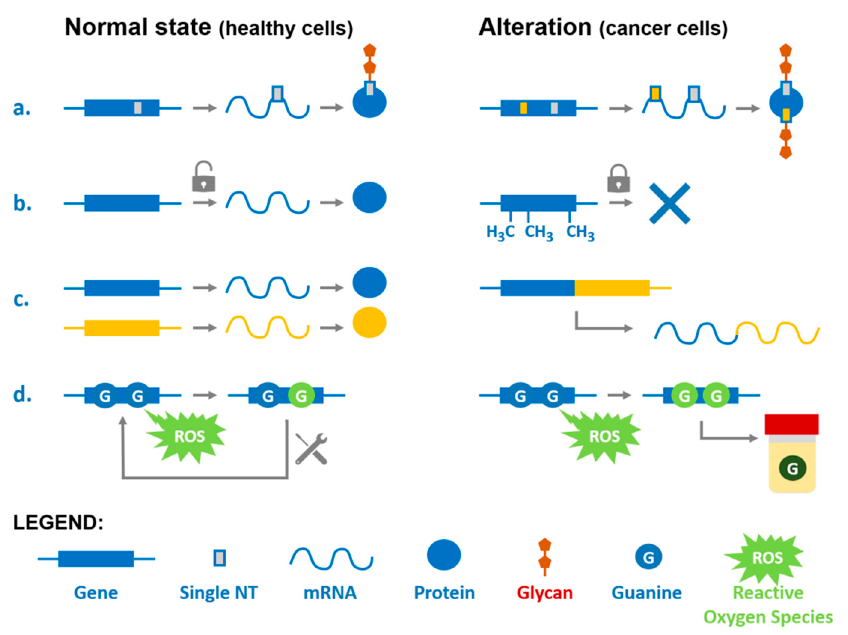
Figure 6. DNA changes associated with PCa. Schematic presentation of changes associated with PCa on DNA level (right) compared to normal conditions (left): ( a ) changes associated with a single nucleotide change (point mutation), possibly leading to another amino acid present in the protein primary structure and occurrence of new glycosylation site (amino acid sequence), ( b ) regulation of gene expression by hypermethylation of target gene, ( c ) occurrence of fusion genes and ( d ) occurrence of oxidised products, such as 8-hydroxydeoxyguanosine, produced by oxidative stress (dark circle) and found in urine.